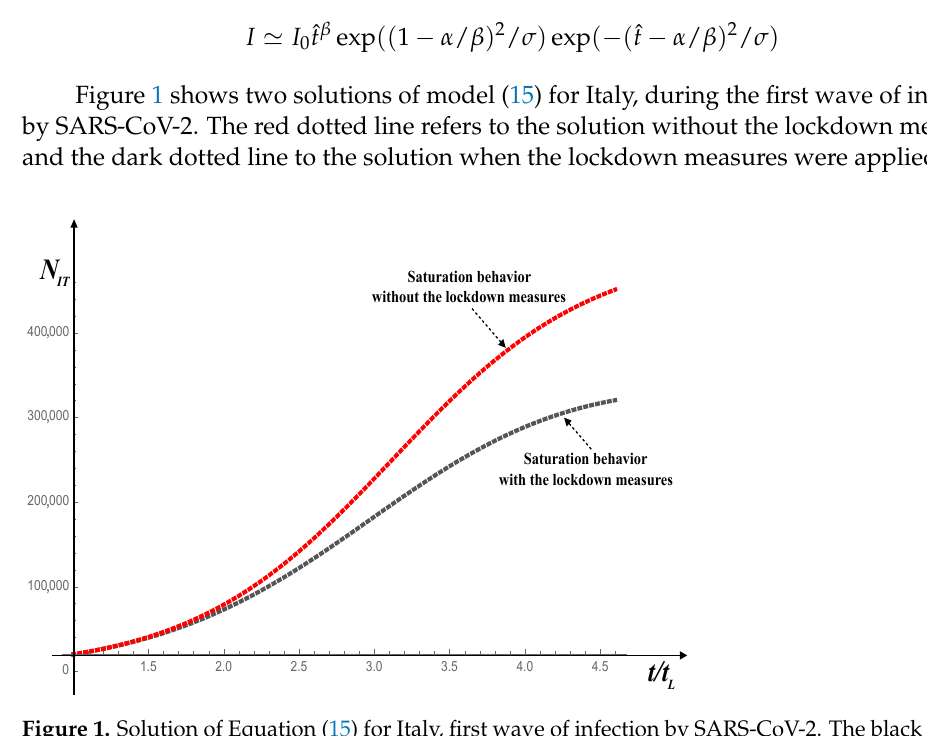
Figure 1. Solution of Equation (15) for Italy, first wave of infection by SARS-CoV-2. The black and red dotted lines refer to solutions of Equation (15) with and without application of lockdown measures, respectively. The values of parameters are I 0 = 5,000, K = 150,000, α = 1.5, and β = 0.1,